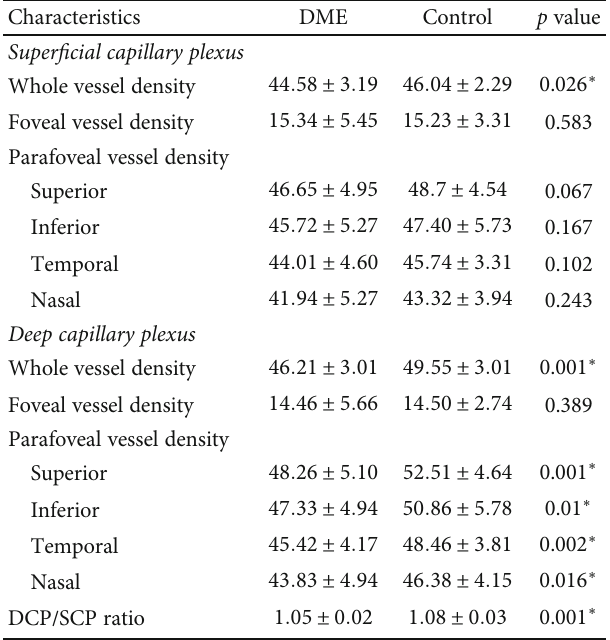
Figure 1: (a, b) Best-corrected visual acuity (BCVA) and central macular thickness (CMT) improved signi fi cantly compared to baseline during the observation period. ∗ p < 0 : 001 ; repeated measures ANOVA. Table 2: Vessel density in patients with DME and